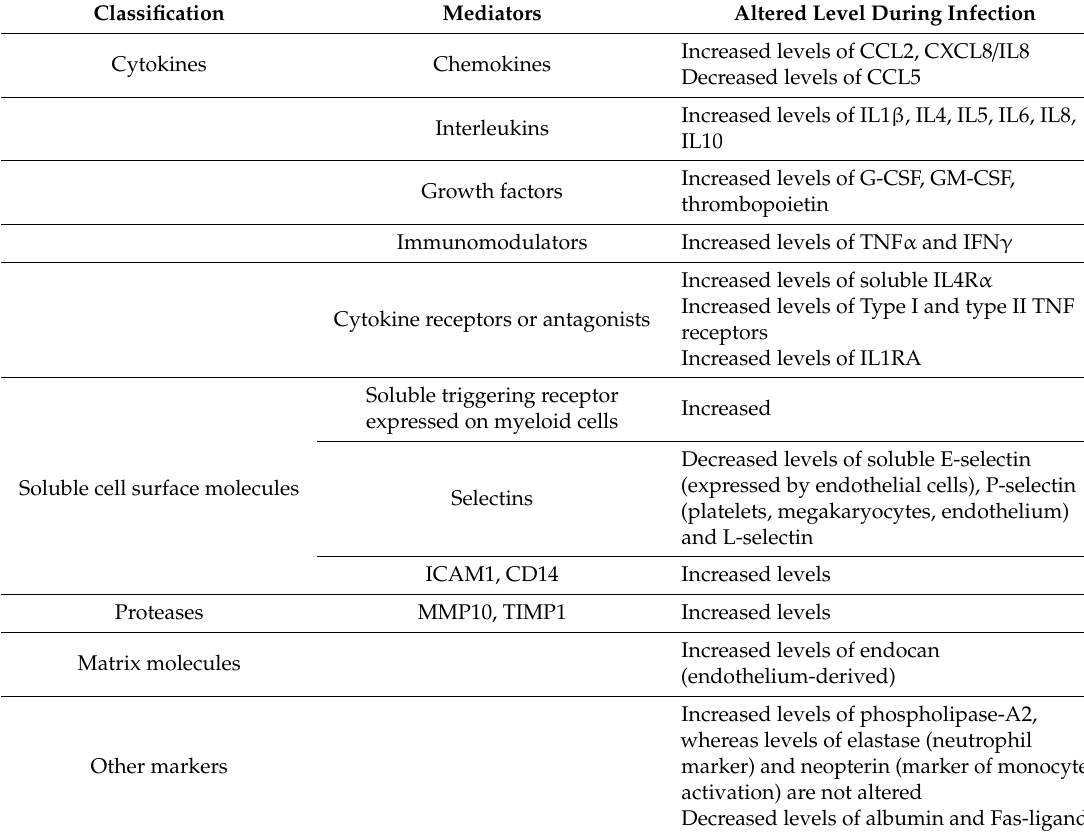
Table 1. The acute phase reaction in leukemia patients with febrile neutropenia; a summary of important studies in patients with hematological malignancies and severe chemotherapy-induced pancytopenia in peripheral blood due to chemotherapy-induced bone marrow failure. The patients included in most of these studies had fever ( > 38.5 ◦ C), increasing C-reactive protein (CRP) levels to > 50 mg / L and either documented or likely bacterial infections [10–24] 1